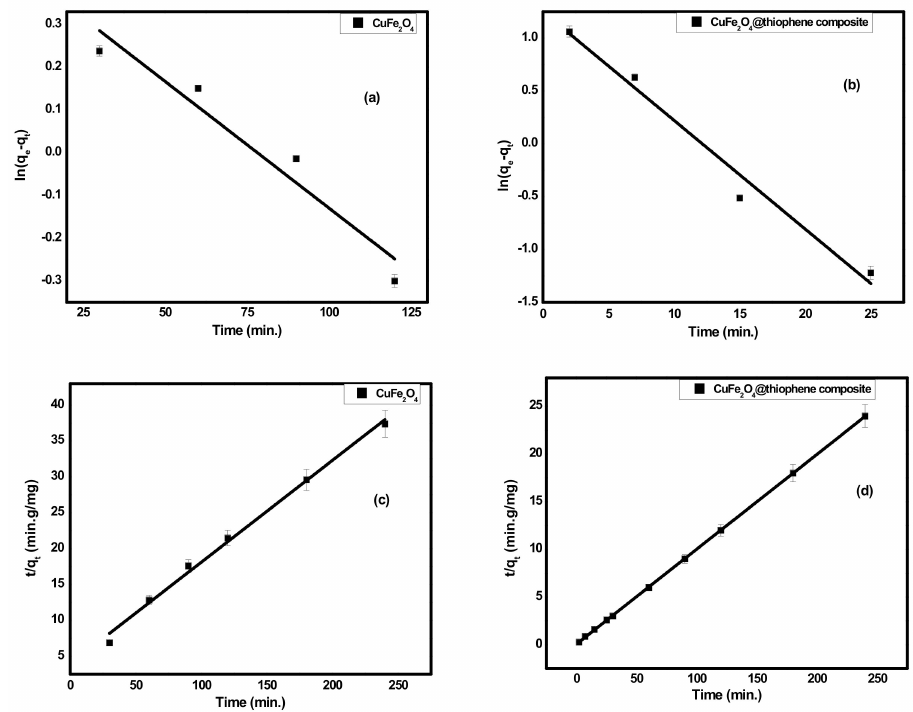
Figure 7. ( a , b ) kinetics plot of pseudo first order for adsorption of Hg(II) ions onto CuFe 2 O 4 and CuFe 2 O 4 @Polythiophene composite; respectively and ( c , d ) kinetics plot of second order for adsorption of Hg(II) ions onto CuFe 2 O 4 and CuFe 2 O 4 @Polythiophene composite, respectively.